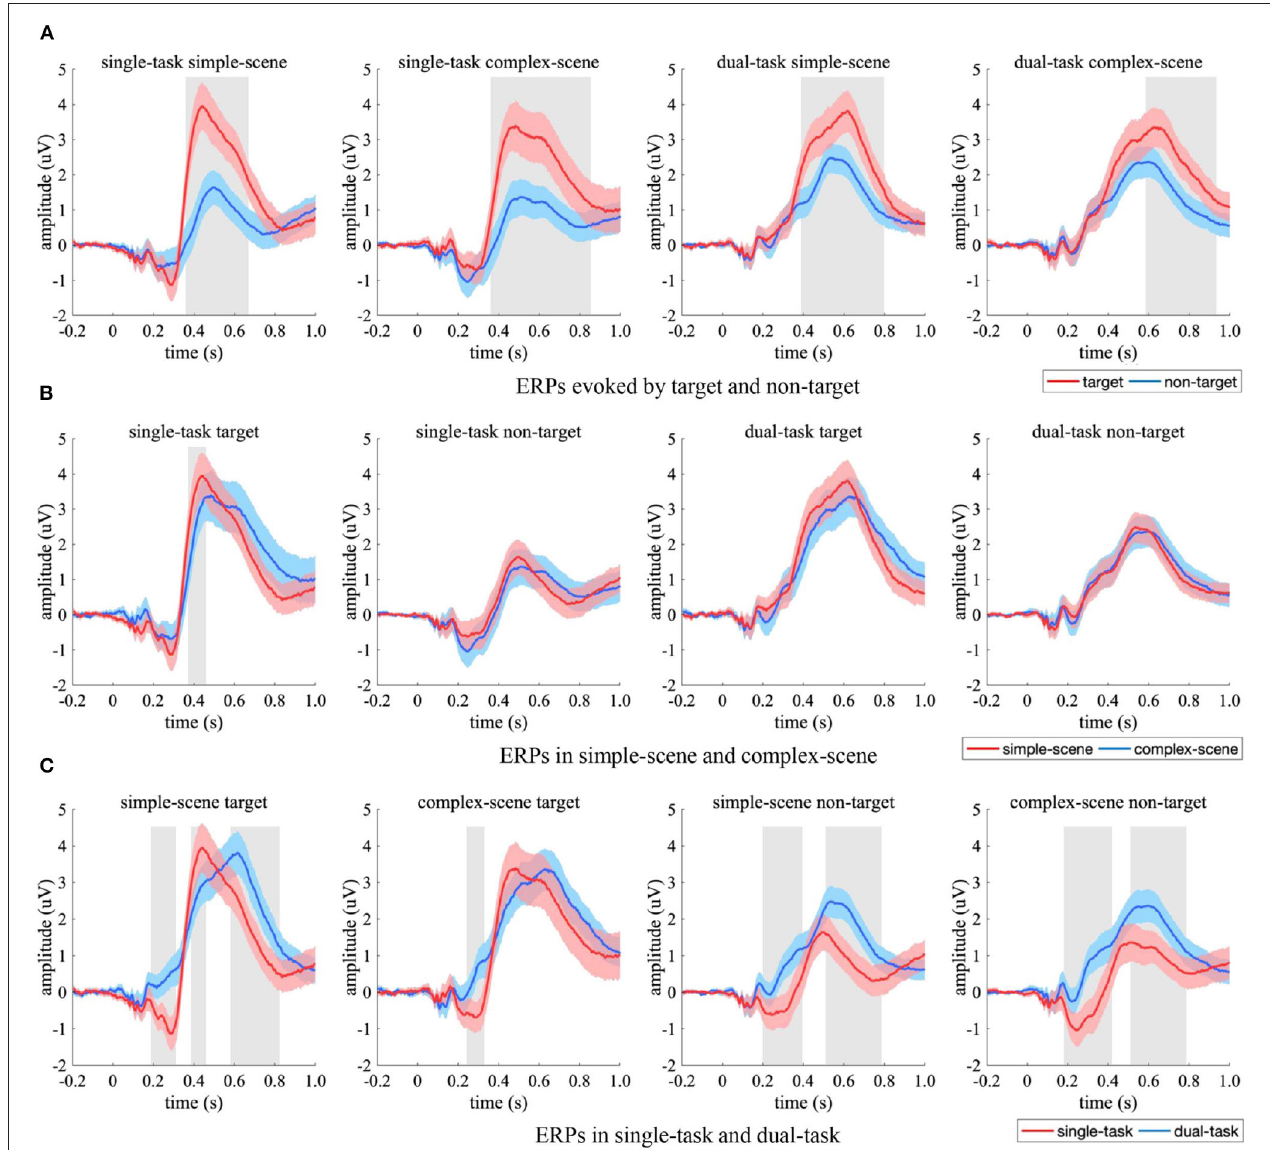
FIGURE 7 | Comparison of ERPs in the centro-parietal EEG electrodes. (A) ERPs evoked by target (red) and non-target (blue), (B) ERPs in simple-scene (red) and complex-scene (blue), (C) ERPs in single-task (red) and dual-task (blue). The shaded area indicates 95% confidence interval. Shaded gray regions denote the time intervals when there are significant differences between the two conditions ( p < 0.05, two-sample t -test, FDR